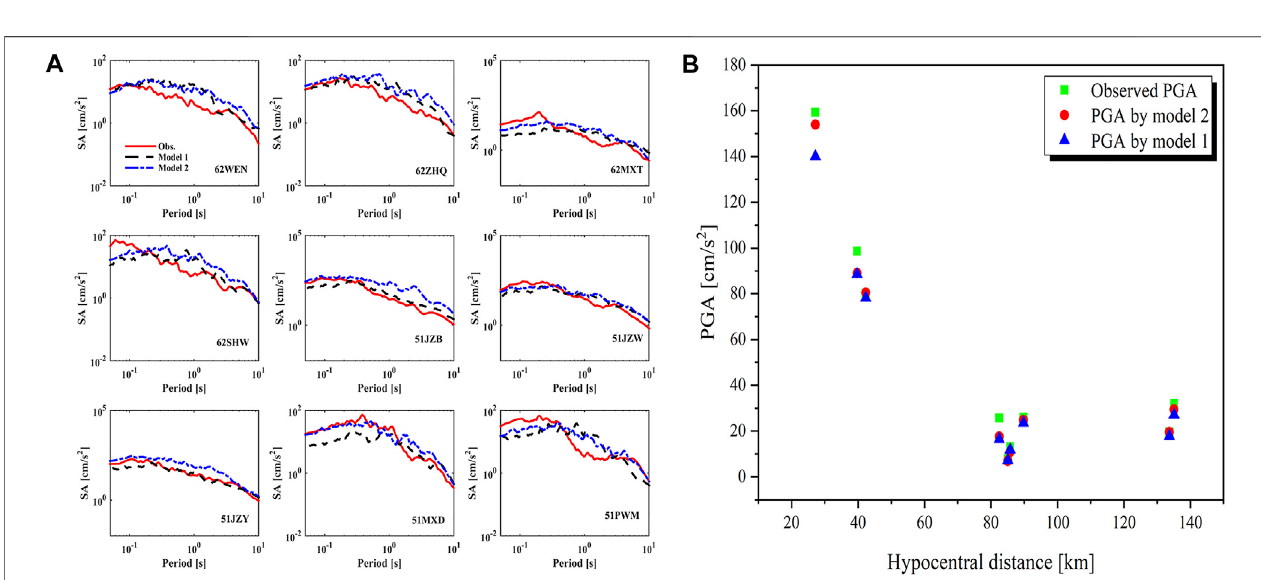
FIGURE 5 | Far- fi eld received energy calculated by the dynamic corner frequency [ (A) : the scaling factor, H ij , is not considered; (B) : the scaling factor, H ij , is considered]. The black solid line, red dotted line, blue dotted line, and pink dotted lineindicate that the subfaultsizes are 1, 2, 3, and 6, respectively. The pink dotted line represents the result obtained by stochastic point-source model.